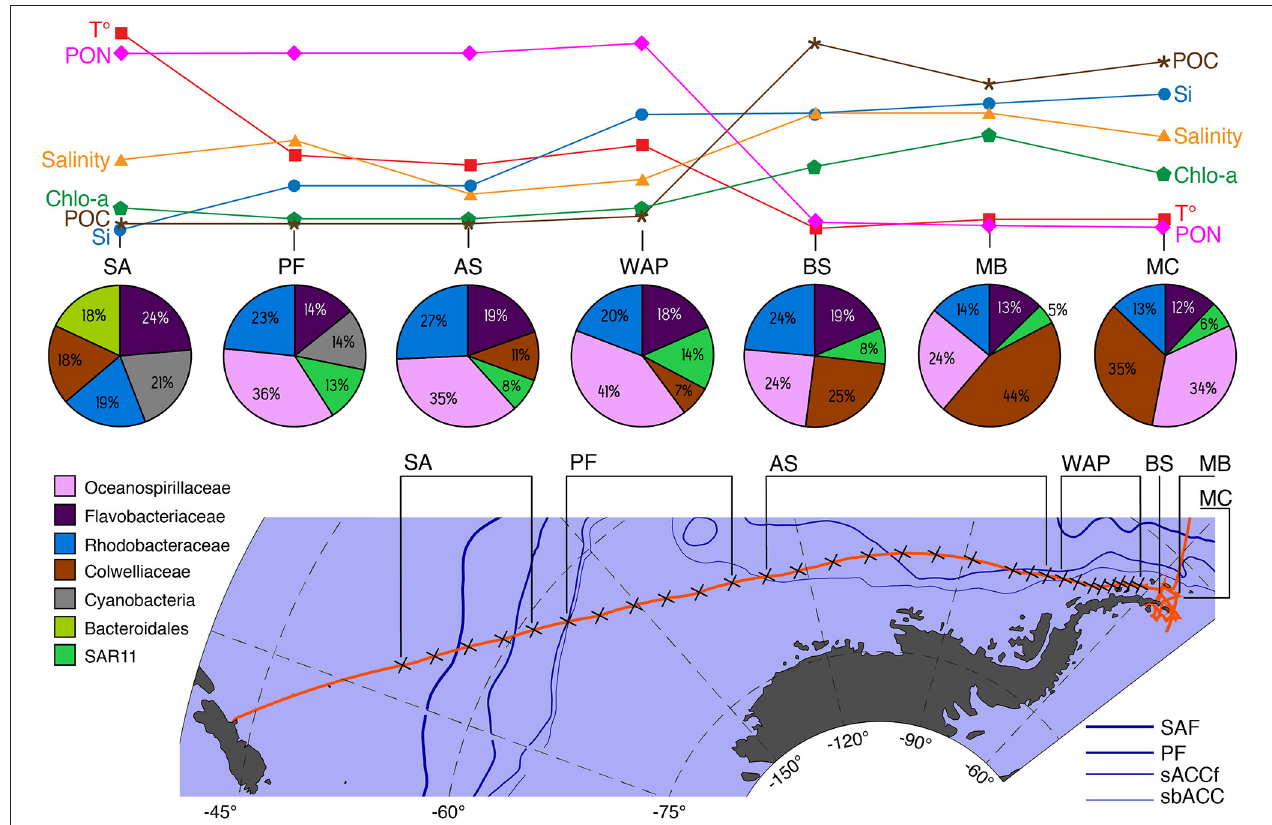
FIGURE 8 | Conceptual description of major taxonomic changes in the upper layer (0, 7, and 10m) of 16S rRNA-based microbial communities in relation to key physical and chemical environmental parameter and oceanographic features that drive community changes along the spatial transect from Christchurch-New Zealand to South Shetland Islands. Variable abbreviations: T ◦ , temperature ◦ C; PON, particulate organic nitrogen; Salinity, Chlo-a, total chlorophyll; POC, particulate organic carbon; Si, silicic acid. Site abbreviations: SA, Subantarctic; PF, Polar Front; AS, Amundsen Sea; WAP, West Antarctic Peninsula; BS, Bransfield Strait; MB, Maxwell Bay; MC, Marian Cove. Current abbreviations: SAF, Subantarctic Front; PF, Polar Front; sACCf, southern Antarctic Circumpolar Current front; sbACC, southern boundary Antarctic Circumpolar